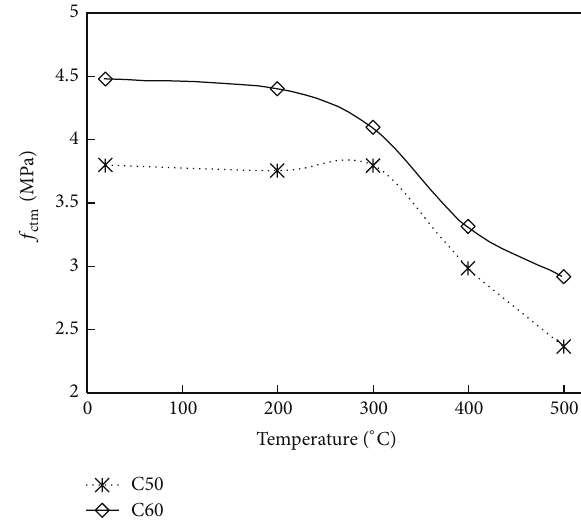
Figure 6: Compressive strength of HPC at elevated temperature.